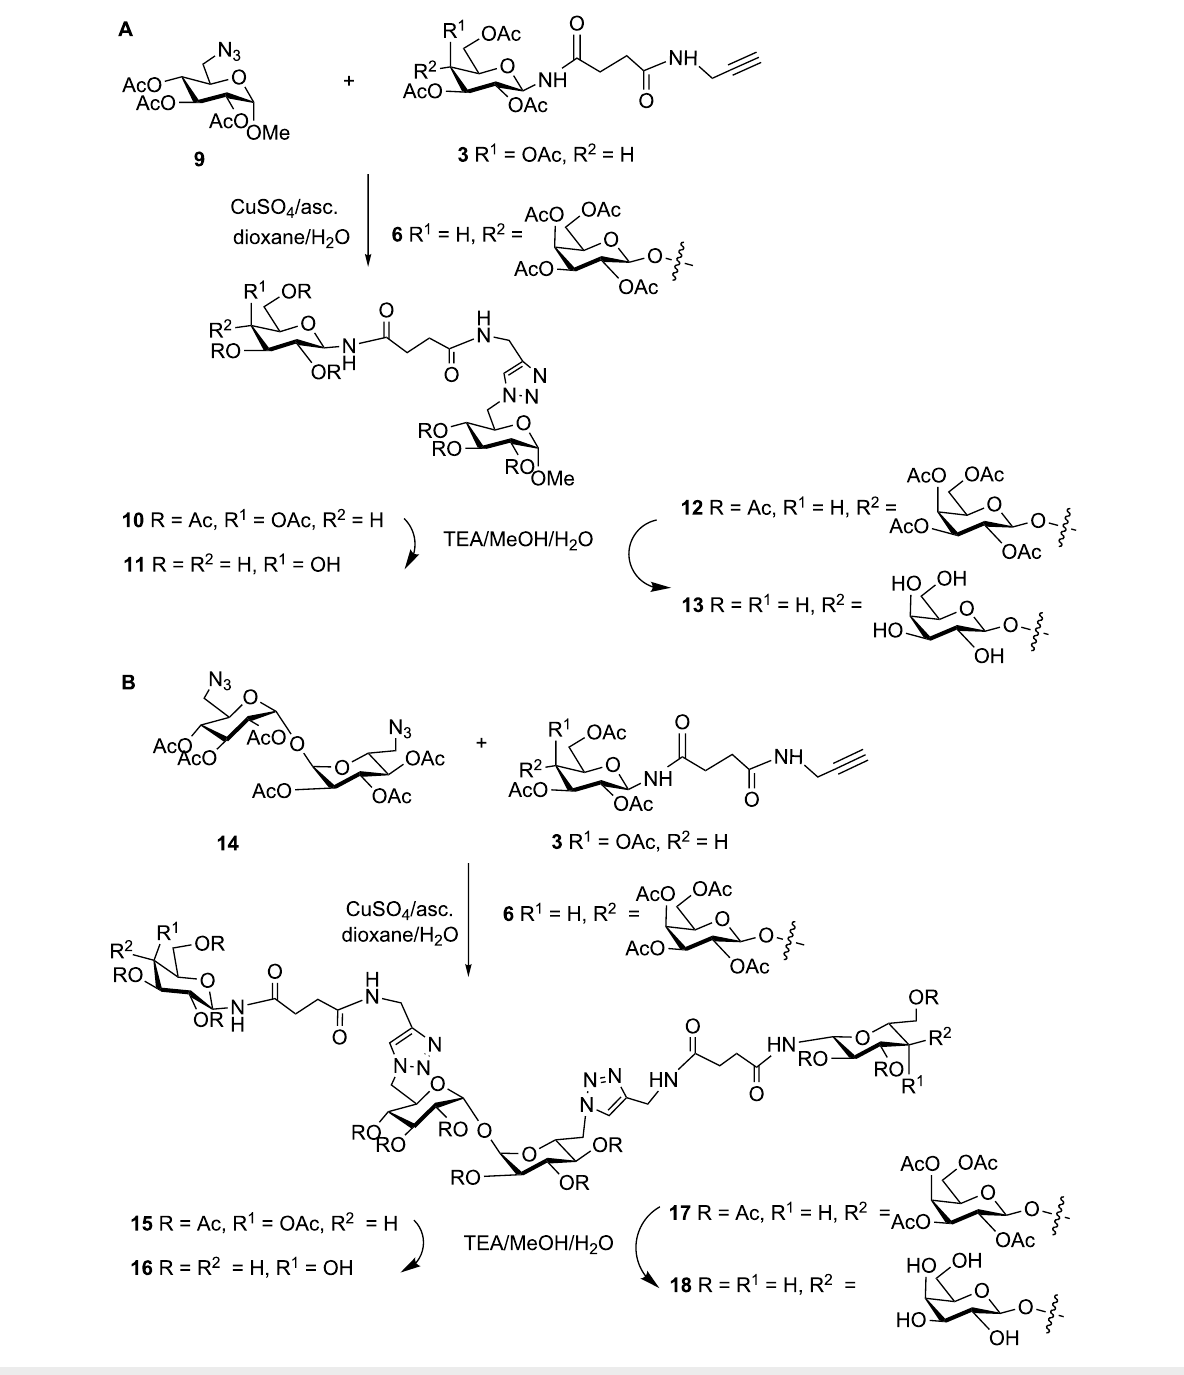
Scheme 2: Synthesis of the mono-(A)- and di-(B)- N -galactopyranosides and lactosides.